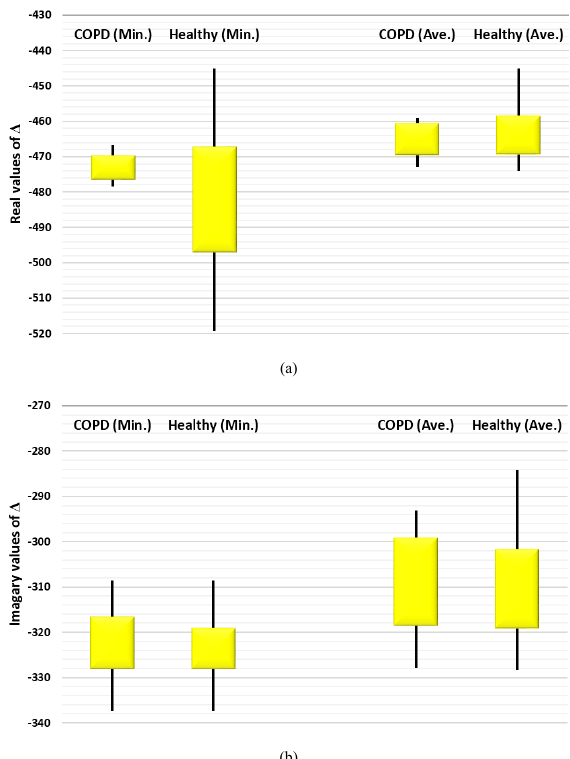
Figure 3. The saliva permittivity features in the two groups of COPD and healthy: (a): Real and (b) Imagery values Note . COPD: Chronic obstructive pulmonary